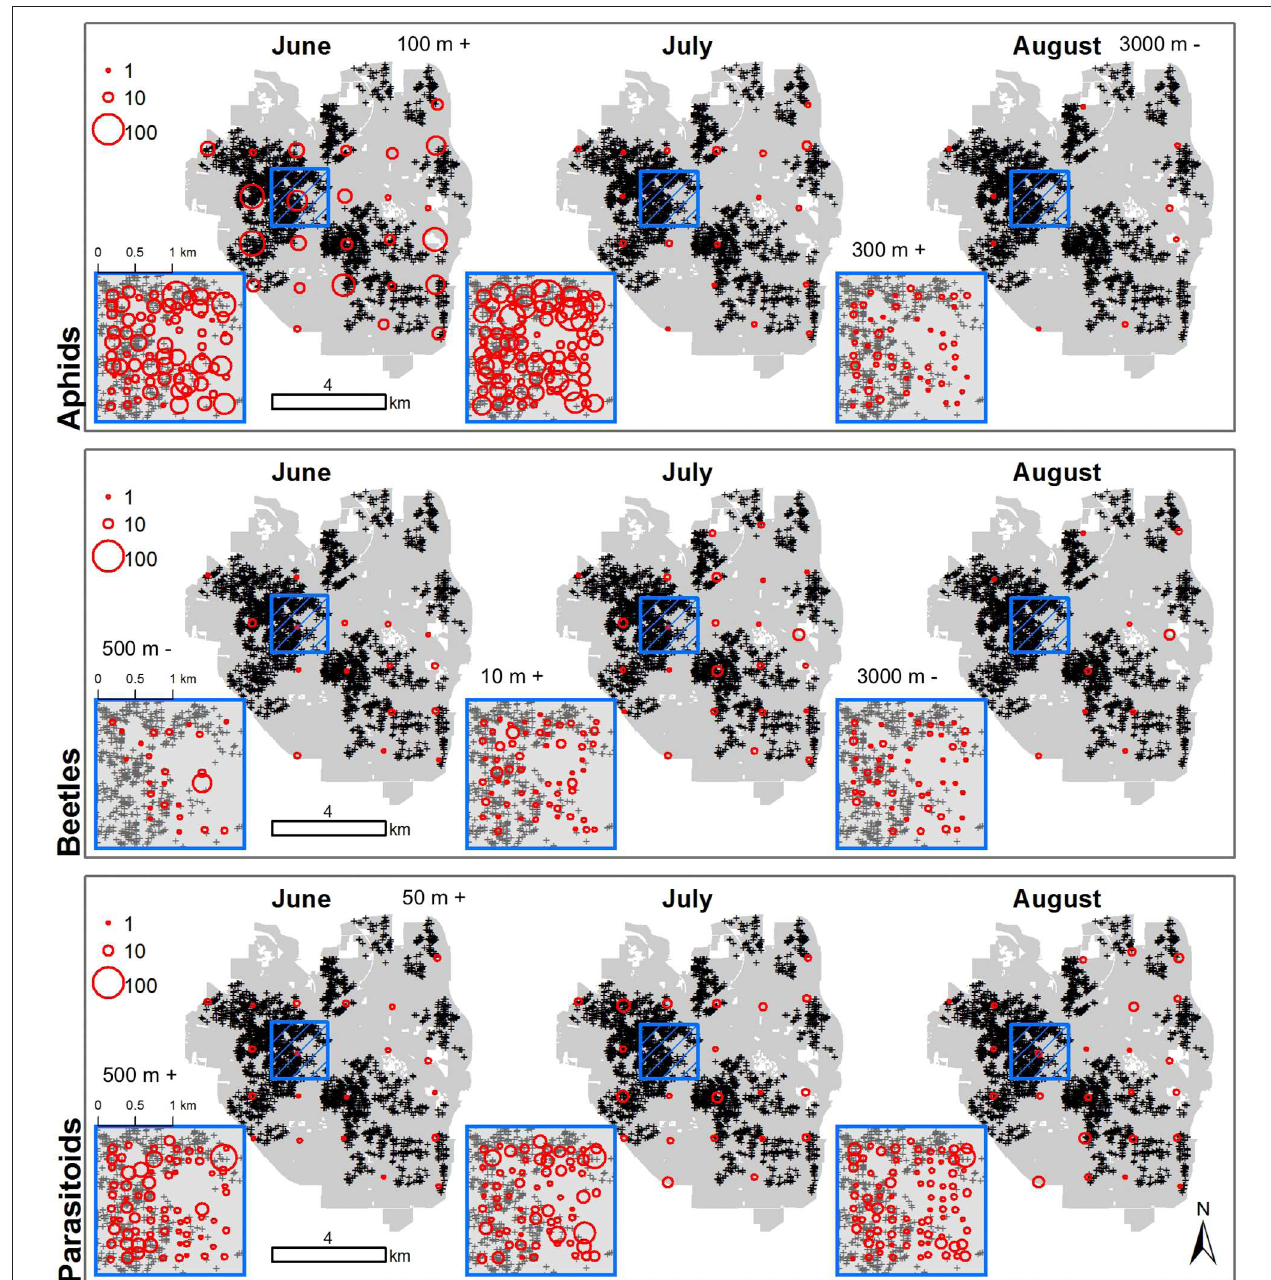
FIGURE 5 | Arthropods are sensitive to urban gardens at different spatio-temporal scales. The sizes of red, open circles indicate the abundance of aphids (top row), ladybird beetles (middle row), and parasitoid wasps (bottom row) in June (first column), July (second column) and August (third column) 2013. Small blue box indicates position of the local plot, which covers downtown Ann Arbor, MI and adjacent neighborhoods with 100 sampled points placed an average of 128m apart. Larger blue box is an enlarged view of the local plot. The landscape plot covers the entire city landscape with 28 points placed an average of 1,470m apart. Easement gardens are indicated by black and grey plus signs. Local and landscape plots in each month are labeled above plots with the spatial scale for which gardens had a significant positive ( + ) or negative (–) effect on abundances.